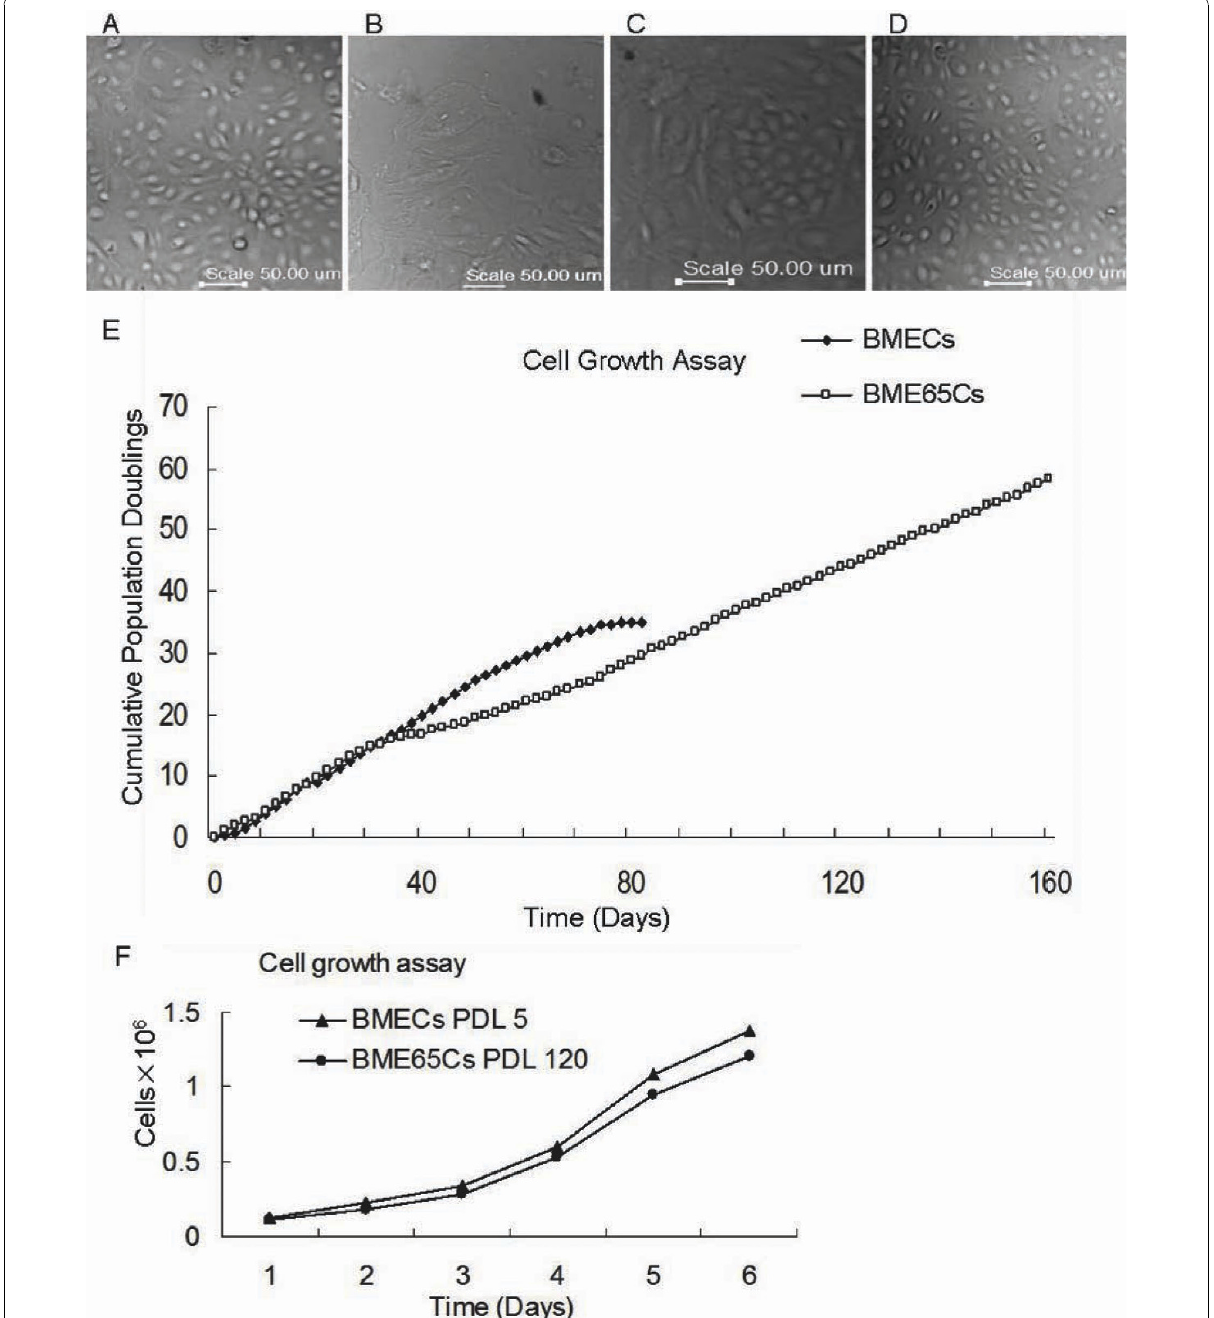
Figure 1 Cell morphology and cell growth rate of BME65Cs cells . A . Phase-contrast images of in vitro cultivated, early passage BMECs cells (PDL 10) with typical morphologies. B . Senescent BMECs cells (PDL 34) with an increased size. C . The initially isolated population of immortalised epithelial-like cells (BME65Cs). D . BME65Cs cells (PDL 120) with the typical cobblestone pattern of freshly isolated primary BMECs cells. Bars: 50 μ m. E . Growth curve of BME65Cs and BMECs cells. To determine growth rates, primary (PDL 2) and immortal mammary epithelial cells (PDL 41) were plated at a density of 3 × 10 5 cells/10 cm dish using culture conditions as described above. At 80% confluency, cells were trypsinised and subcultured every two days, and cumulative population doublings based on cell numbers was calculated. Normal BMECs cells entered the senescent state at PDL 34, and spontaneously immortalised BME65Cs colonies were generated at this stage. F . Growth rates of primary BMECs cells (PDL 5) and immortal BME65Cs cells (PDL 120). Cells were plated at a density of 1 × 10 5 cells/10 cm dish for over 6 days of continuous culture, and cell numbers were counted each day. A similar increase in growth rate was observed between early passage MECs and immortalised BME65Cs